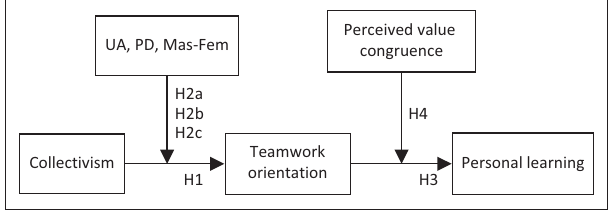
FIGURE 1: Conceptual